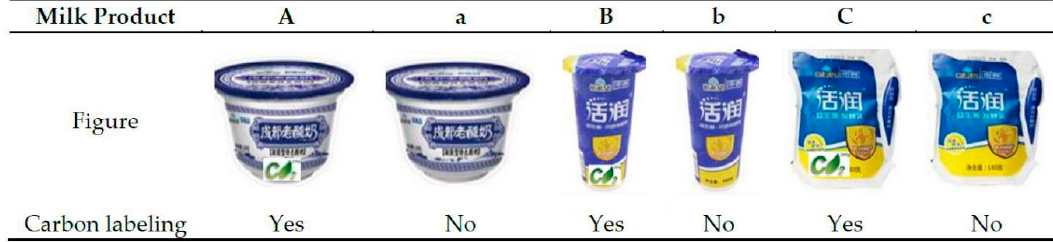
Figure 3. The self-designed carbon label. The sale’s target group involved 208 (= 67 + 88 + 60 + 67 − 24 − 50) students in the four experimental classes who did not participate in the focus group discussions and the auction experiment. Sixteen students were unwilling to join, and the other 192 were finally engaged in the selling experiment. Each student joining the experiment received one cash coupon with his or her student ID, which allowed them to purchase one specific type of milk product once. After a student bought a milk product, his or her cash coupon would be collected. The selling experiment was implemented in three consecutive weeks, and one week corresponds to one period. This study designed three price premium levels based on prior studies on the price premiums of the carbon-labeled milk, as Table 3 notes [12]. Table 3. Price premiums in different sales periods. Period